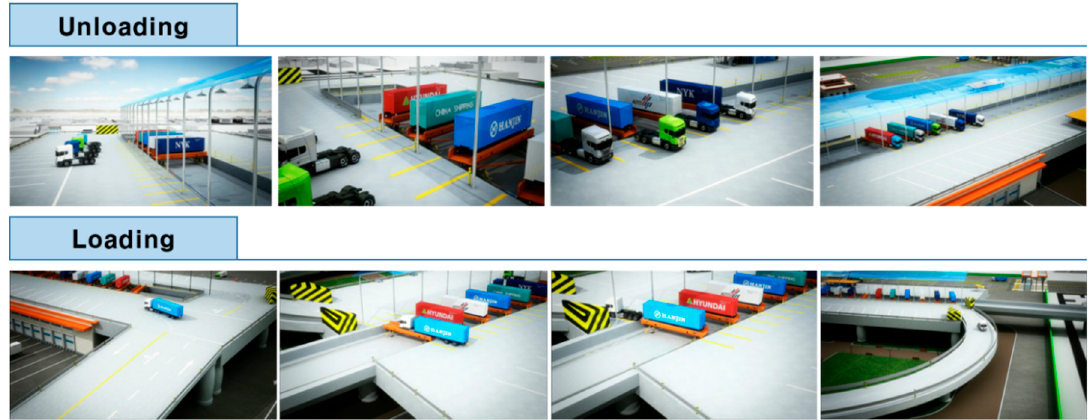
Figure 3. Conceptual diagram of freight unloading and loading in ACTS.